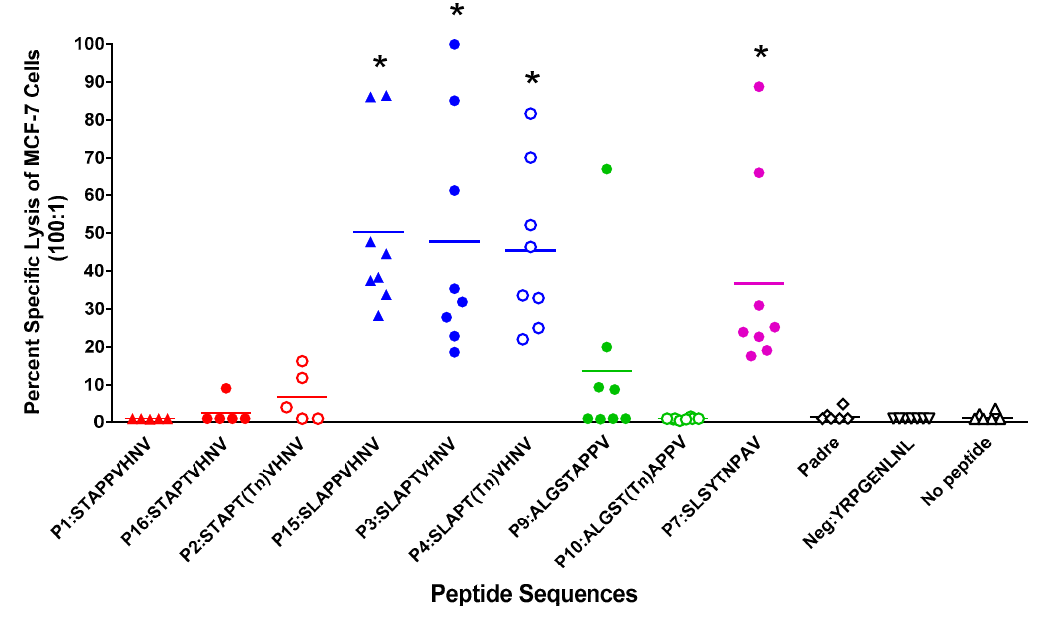
Figure 3. In vitro stimulation of T cells from normal post-menopausal HLA-A*0201 + women with anchor-optimized or glycosylated MUC1 peptides elicited strong CTL activity. PBLs underwent two rounds of stimulation and sorted CD8 + T cells were subjected to a 51 Cr-release assay. Data represent killing activity of various MUC1-specific CTLs generated against MCF-7 (MUC1 + , HLA-A2 + ) cells used as targets. Effector:target ratio was 100:1 and spontaneous release was less than 15% of complete lysis. * p = 0.008 compared to the negative peptide.